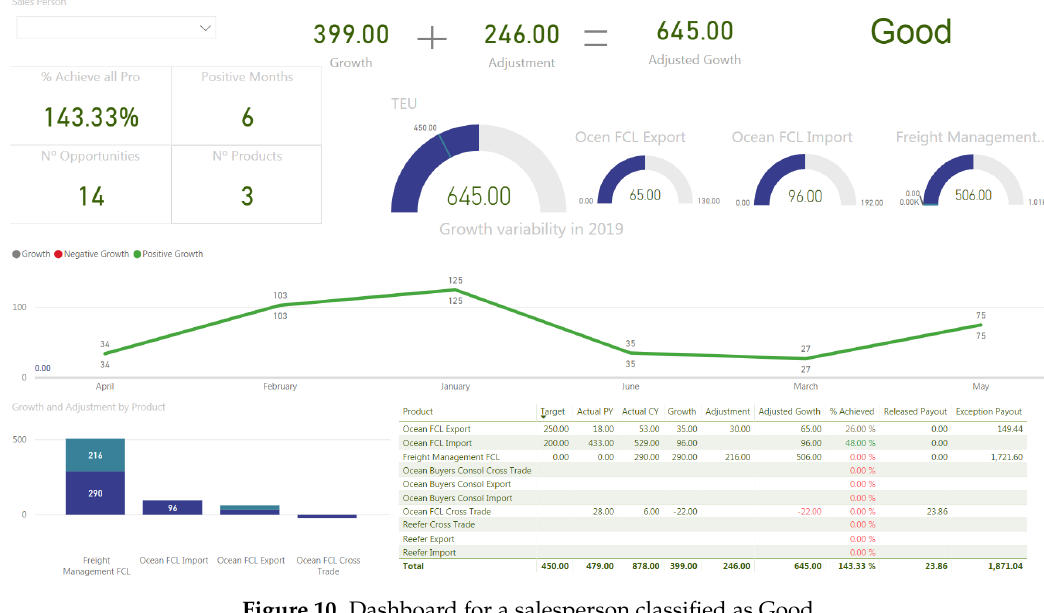
Figure 10. Dashboard for a salesperson classified as Good.